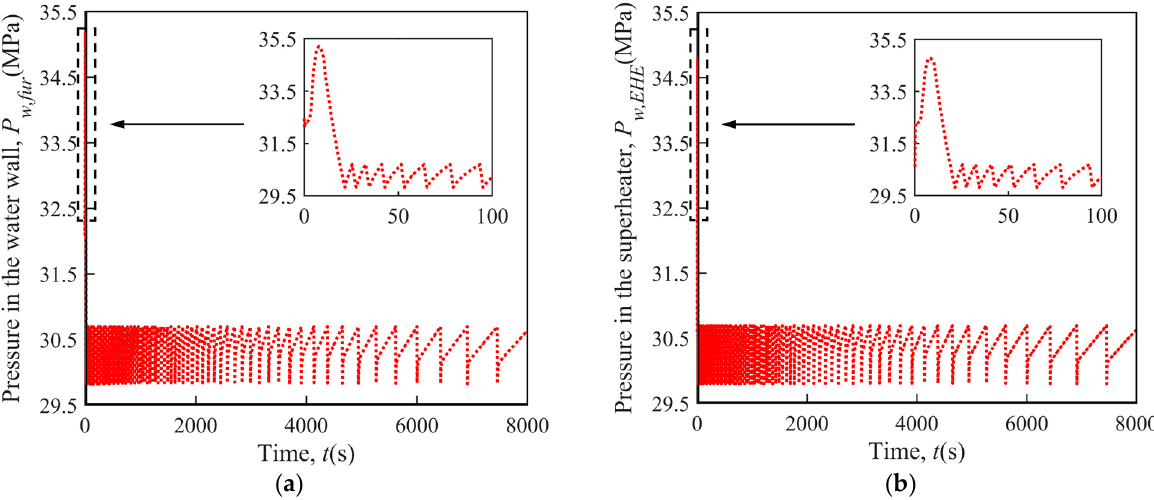
Figure 5. Variation of fluid pressure under sudden electricity failure. ( a ) Water wall; ( b )